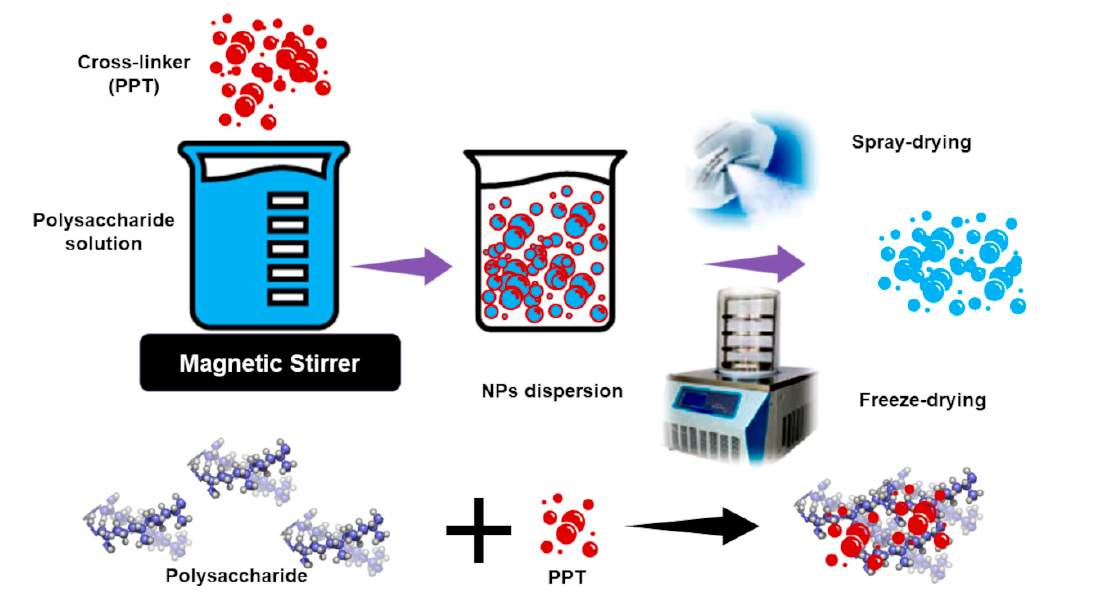
Table 8. Examples of nanosized formulations of BACs developed by using the abovementioned polymers.